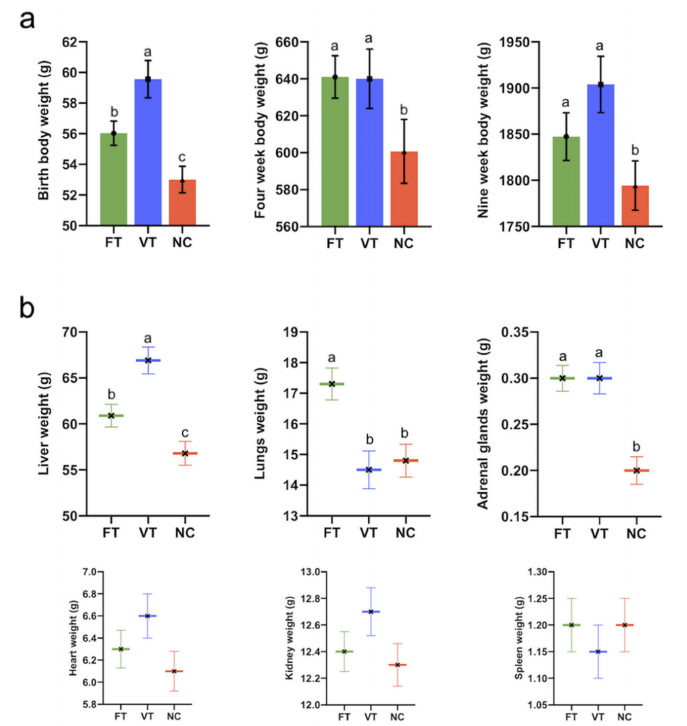
Figure 2. Identification of assisted reproductive technologies (ART)-associated phenotypic and metabolic changes from neonatal to prepuberal age. ( a ) Bars graph shows body weight between o ff spring born after the embryo manipulation during the transfer procedure (FT, green) or vitrified embryos procedure (VT, blue) compared to nonmanipulated (NC, red) from birth to prepuberal age, showing a significant di ff erence between groups. n = 124 FT animals, n = 127 VT animals and n = 79 NC animals. ( b ) XY plot of the wet organ weight of liver, lungs, heart, kidneys, adrenal glands and spleen, showing a significant di ff erence between groups for liver, lung and adrenal gland. n = 52 FT samples, n = 58 VT samples and n = 42 NC samples. Bars and XY plots with di ff erent superscript letters are significantly di ff erent ( p ≤ 0.05). Data represent the least square means and standard errors of the